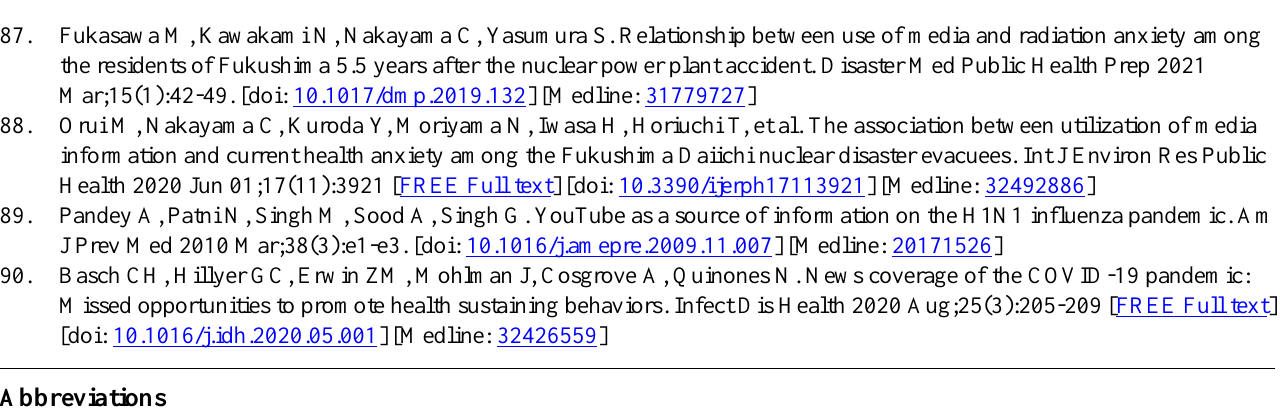
GAD-7: Generalized Anxiety Disorder 7-item